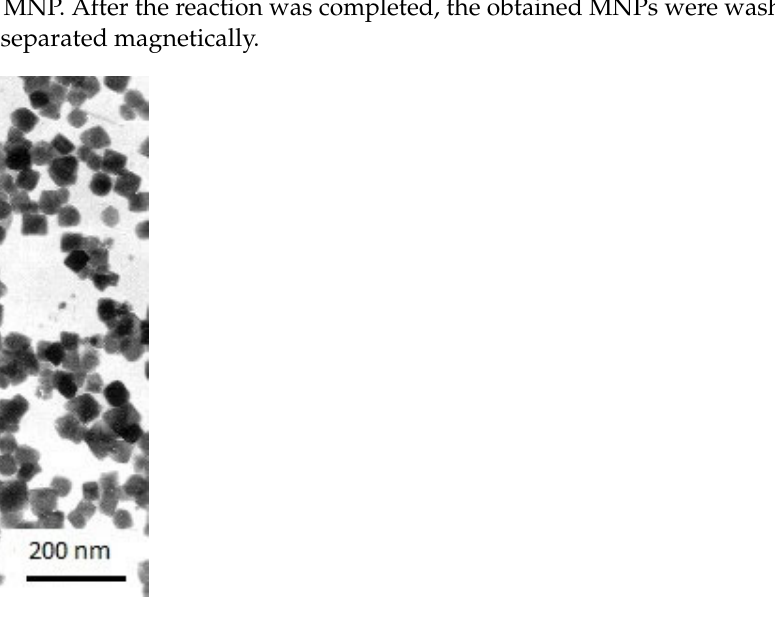
Figure 3. A TEM ‐ image of MNPs synthesized via the partial oxidation of ferrous hydroxide (the Figure 3. A TEM-image of MNPs synthesized via the partial oxidation of ferrous hydroxide (the results obtained in the laboratory of the presenting authors). results obtained in the laboratory of the presenting